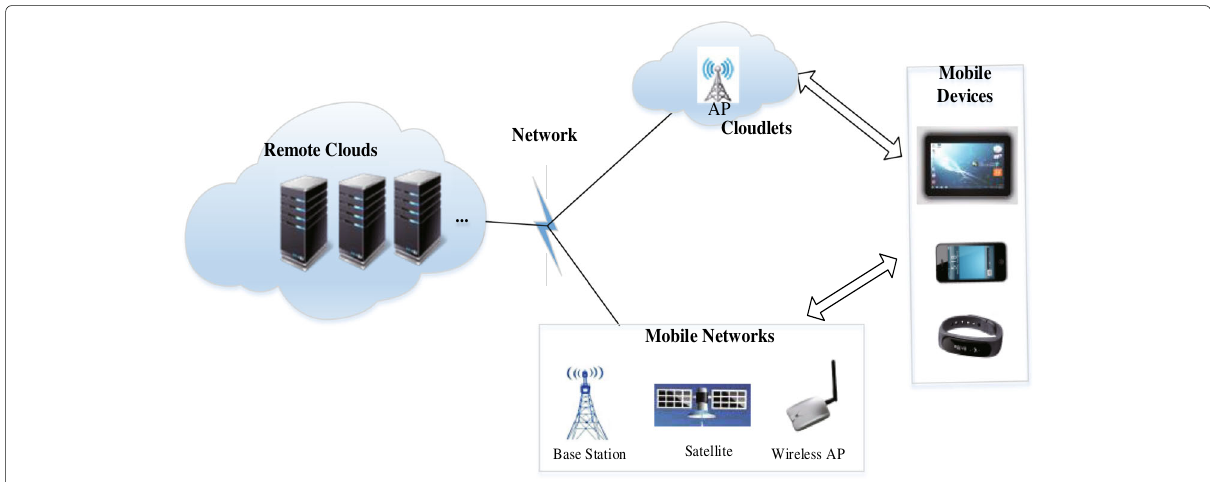
Fig. 2 The architecture of cloudlet communication for mobile devices